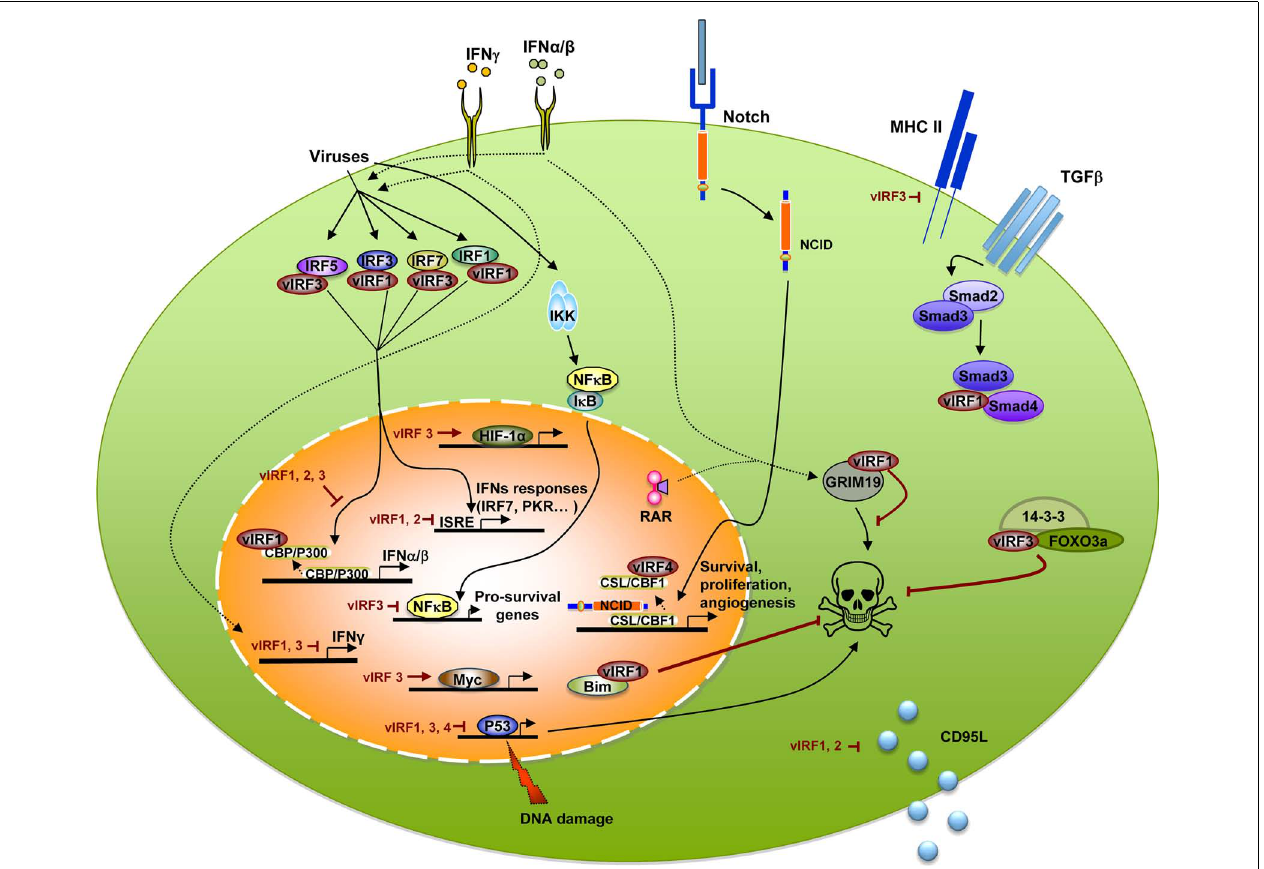
p53-mediated cell death. Other cell death processes affected by vIRFs include vIRF1 binding to GRIM19, vIRF3 interaction with 14-3-3 and FOXO3a, vIRF1 and 2 blockade of CD95L production, and vIRF1-mediated nuclear localization of Bim. In addition to deregulating immune responses and cell death, vIRFs have other roles such as vIRF3 increasing Myc and HIF-1 α transcription and blocking expression of MHC II. vIRF1 blocksTGF- β signaling through binding to Smad3 and Smad4 and vIRF4 binding to the Notch transcription factor, CSL/CBF1 to inhibit activation of Notch target